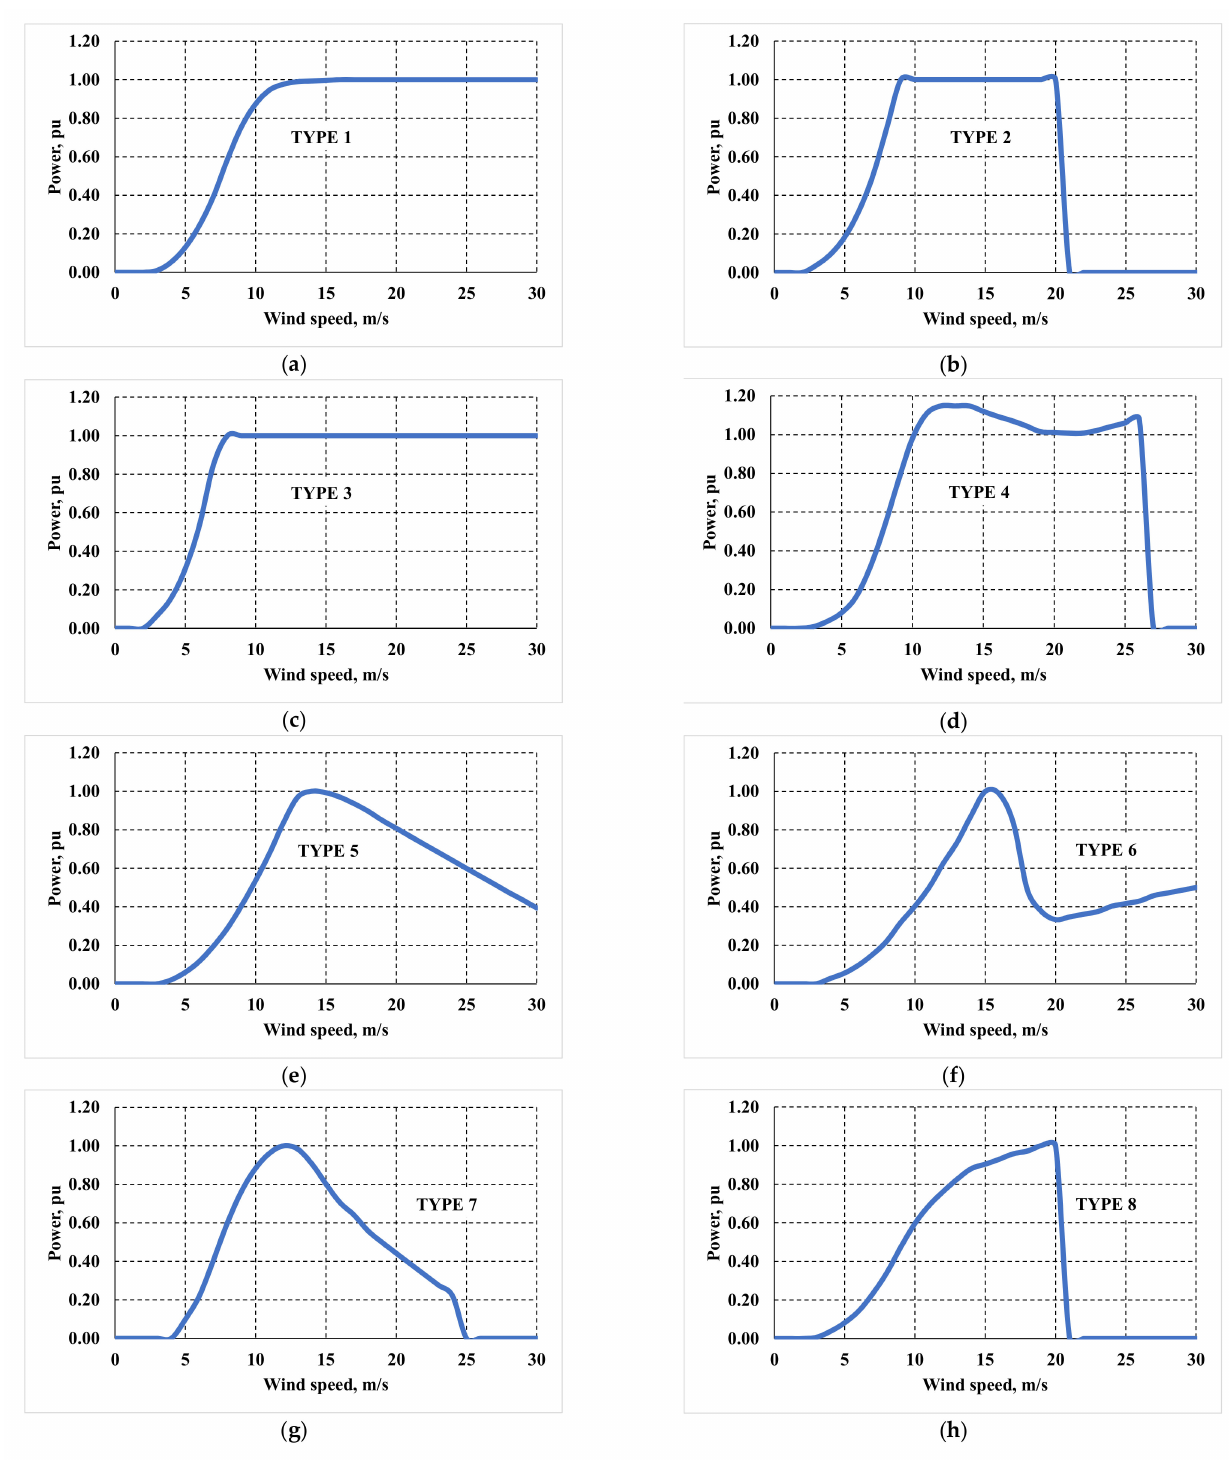
Figure 4. Typical power curves per unit (p.u.), as used in the methodology: ( a ) Type 1; ( b ) Type 2; ( c ) Type 3; ( d ) Type 4; ( e ) Type 5; ( f ) Type 6; ( g ) Type 7; ( h ) Type